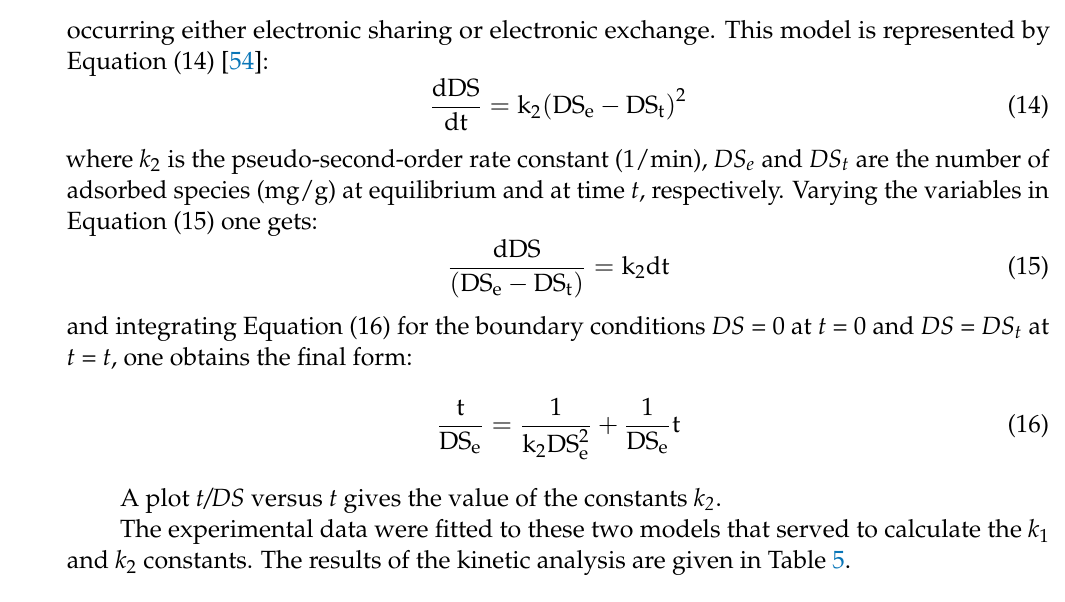
Table 5. Kinetic parameters of diethyl phthalate (DEP)